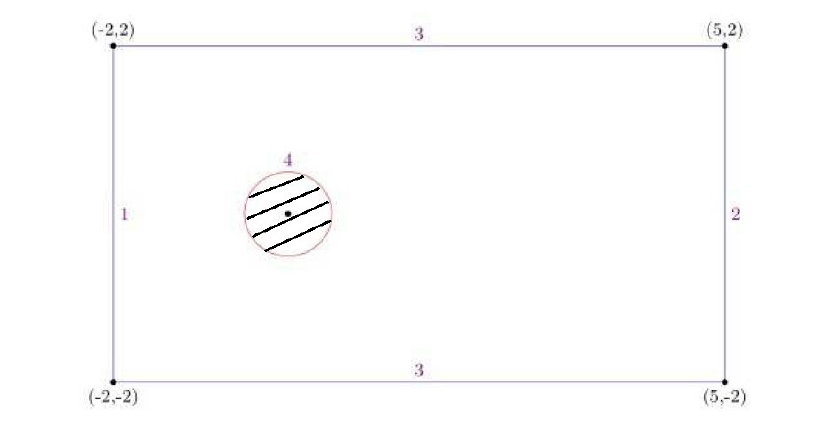
Figure 1. The computational domain and boundary